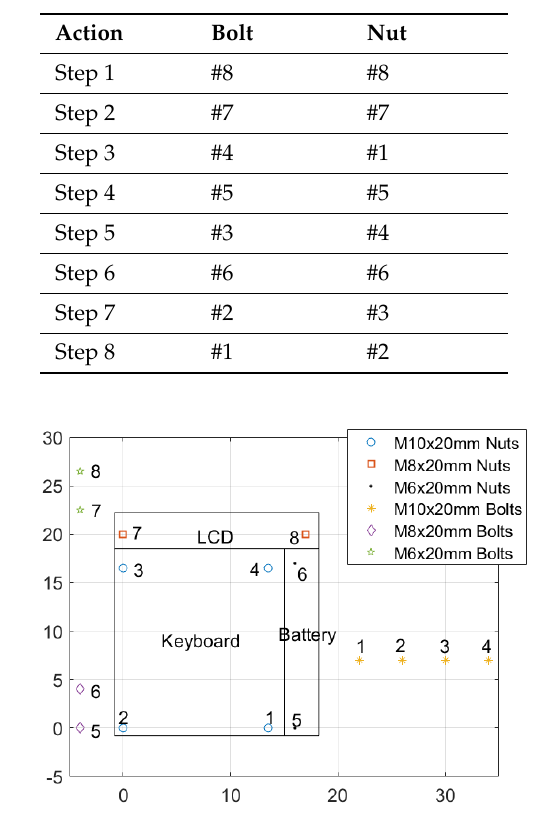
Table 4. Optimal assembly solution obtained from the optimization algorithm.